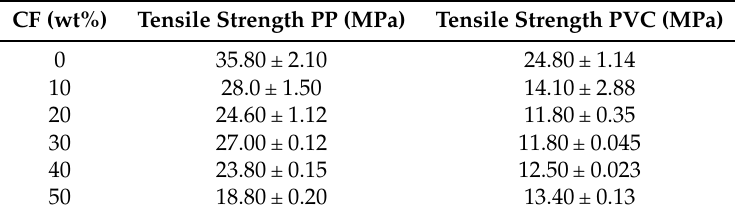
Table 4. Tensile strength for PP and PVC set with different filler content, CF.